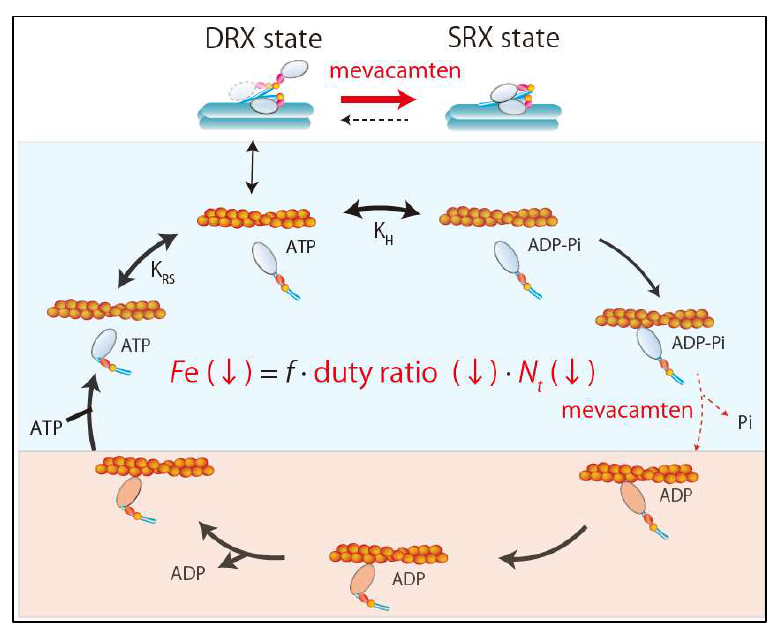
Figure 3. Effects of mevacamten. Mevacamten reduces the ensemble force by combination of reductions in the duty ratio and the number of total number of functionally available myosin heads. SRX, super relaxation; DRX, disordered